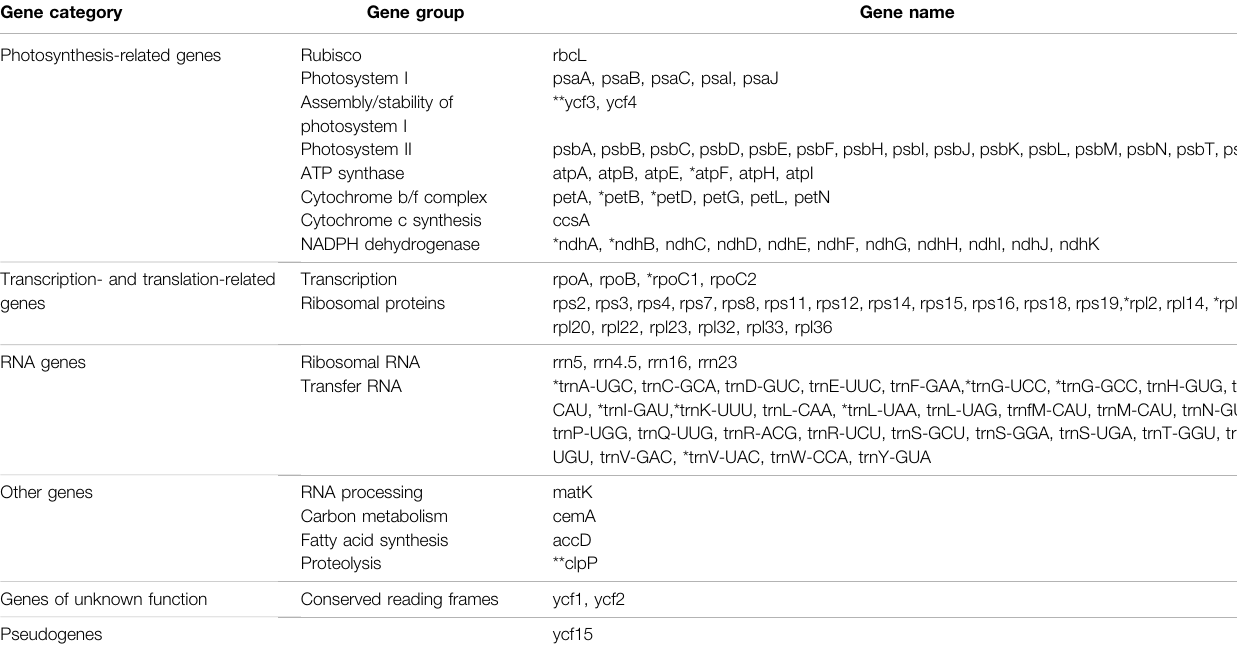
TABLE 2 | Genes in the Catalpa chloroplast genomes. Gene